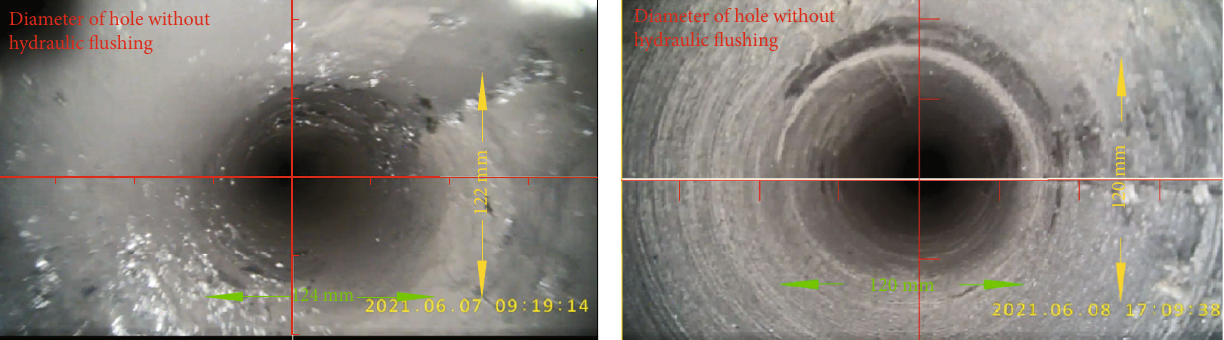
Figure 5: Coal section without the fl ushing hole.